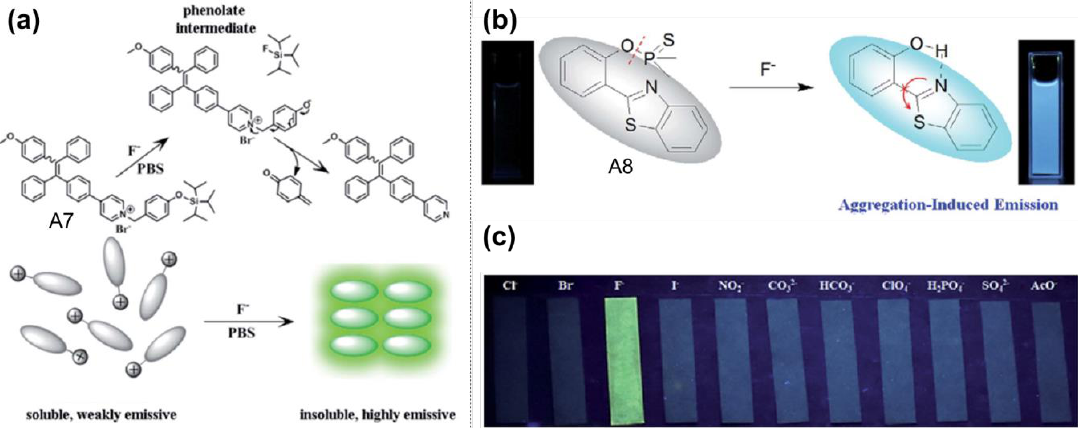
Figure 3. Mechanisms of fluoride sensing for A7 ( a ) and A8 ( b ). ( c ) Photo showing selective emission turn-on response of A8 -coated paper test strips in the presence of fluoride. Reproduced with permission from [48] and [49]. Copyright 2016 and 2018, the Royal Society of Chemistry.